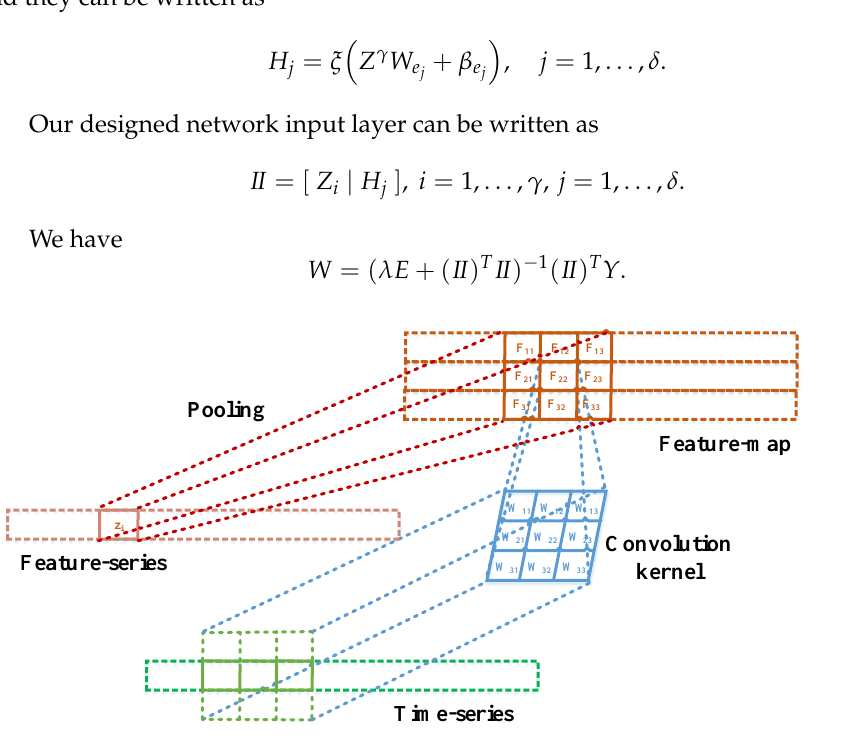
Figure 8. Process of single